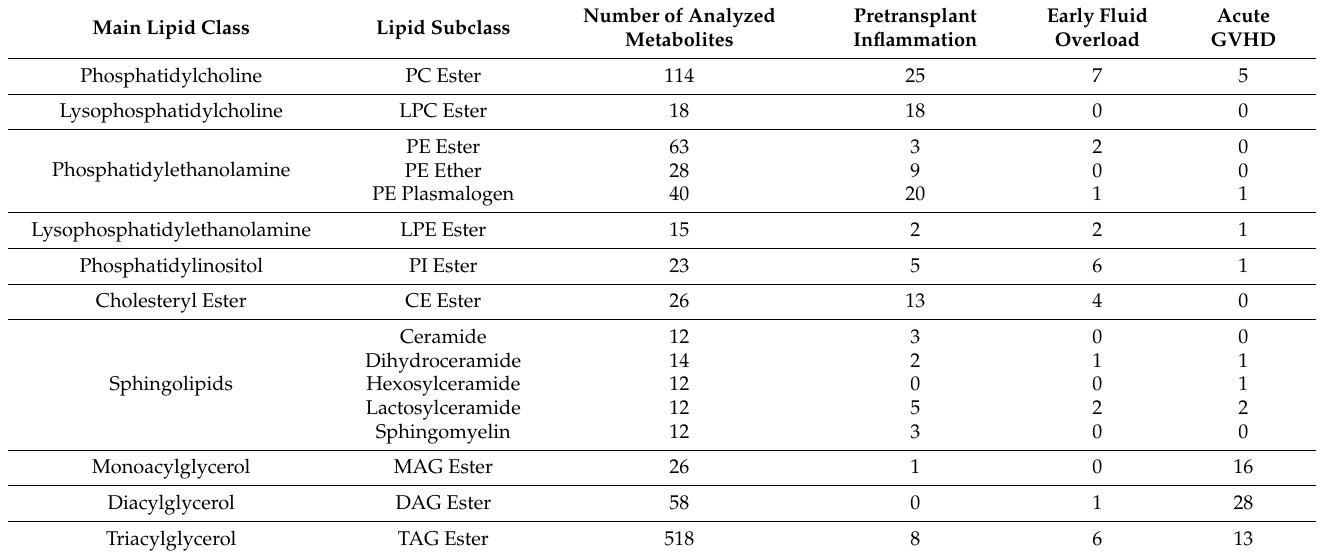
Table 6. The number and classification of lipid species showing significantly different levels when comparing patients with and without pretransplant inflammation, early postconditioning fluid overload and posttransplant acute GVHD. The table presents the total number of analyzed metabolites for each lipid subclass and the number of differentially expressed metabolites that were altered within the different comparing groups (with and without inflammation/fluid overload/GVHD). A simplified visualization of these results is presented in Figure